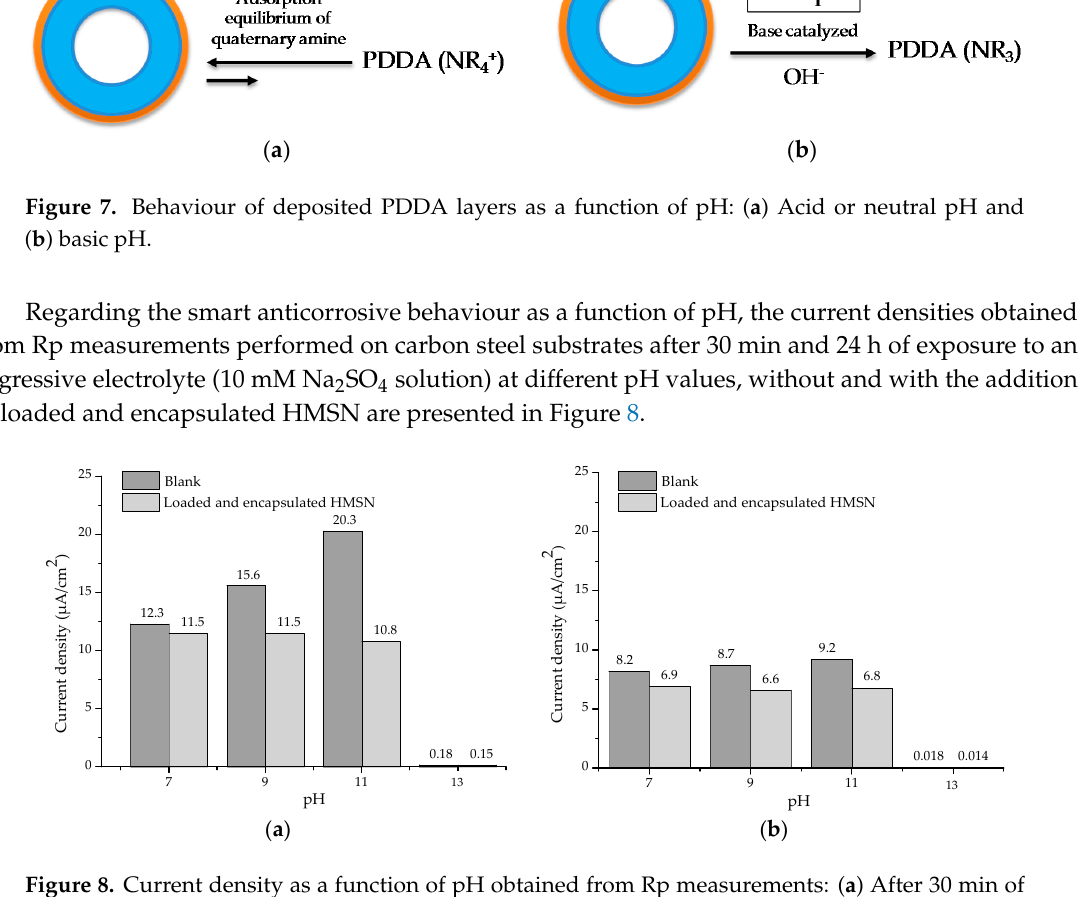
Figure 6. Inhibitor release as a function of pH.